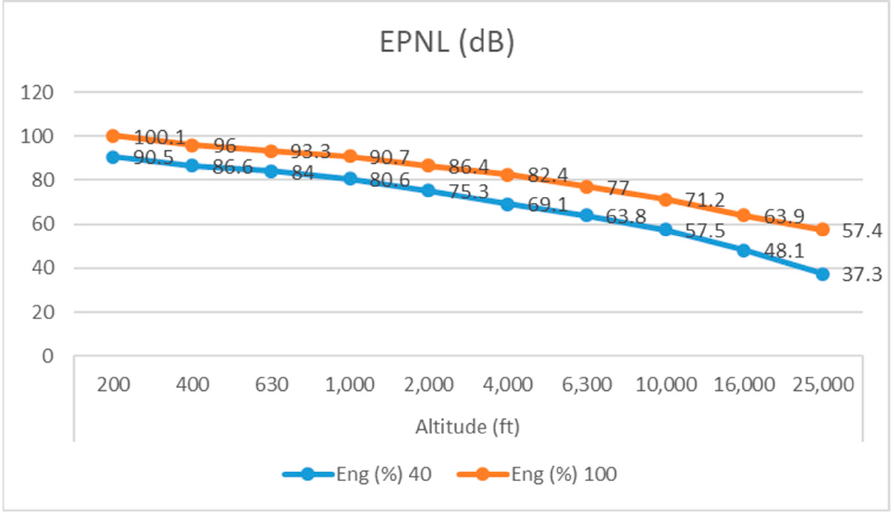
Figure 36. NPD curves, in terms of EPNL, for the DEP configuration.